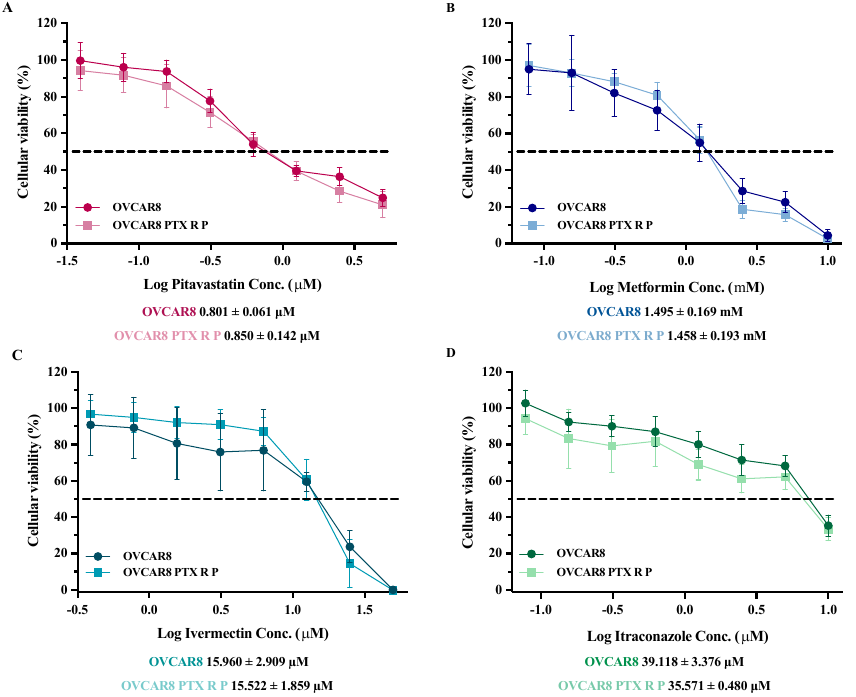
E Figure 1. Cont